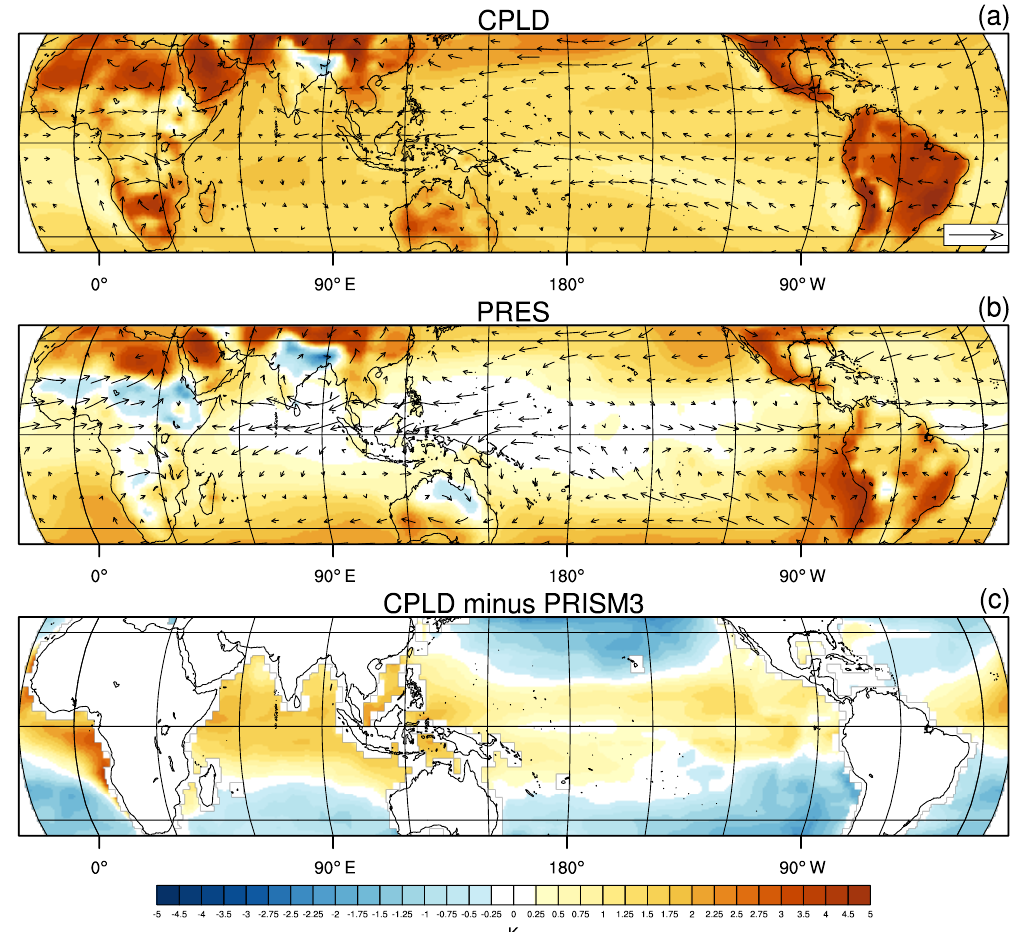
Figure 1. CPLD (a) and PRES (b) multi-model mean, annual mean surface temperature response (shading, units K) and 850hPa wind response (reference vector denotes 3ms − 1 K − 1 ). Prior to computing the multi-model mean, the response in each model is scaled by its tropical mean surface temperature response in CPLD (see Sect. 2.2 and Table 1). (c) CPLD multi-model annual mean sea surface temperature (SST) minus PRISM3 reconstructed